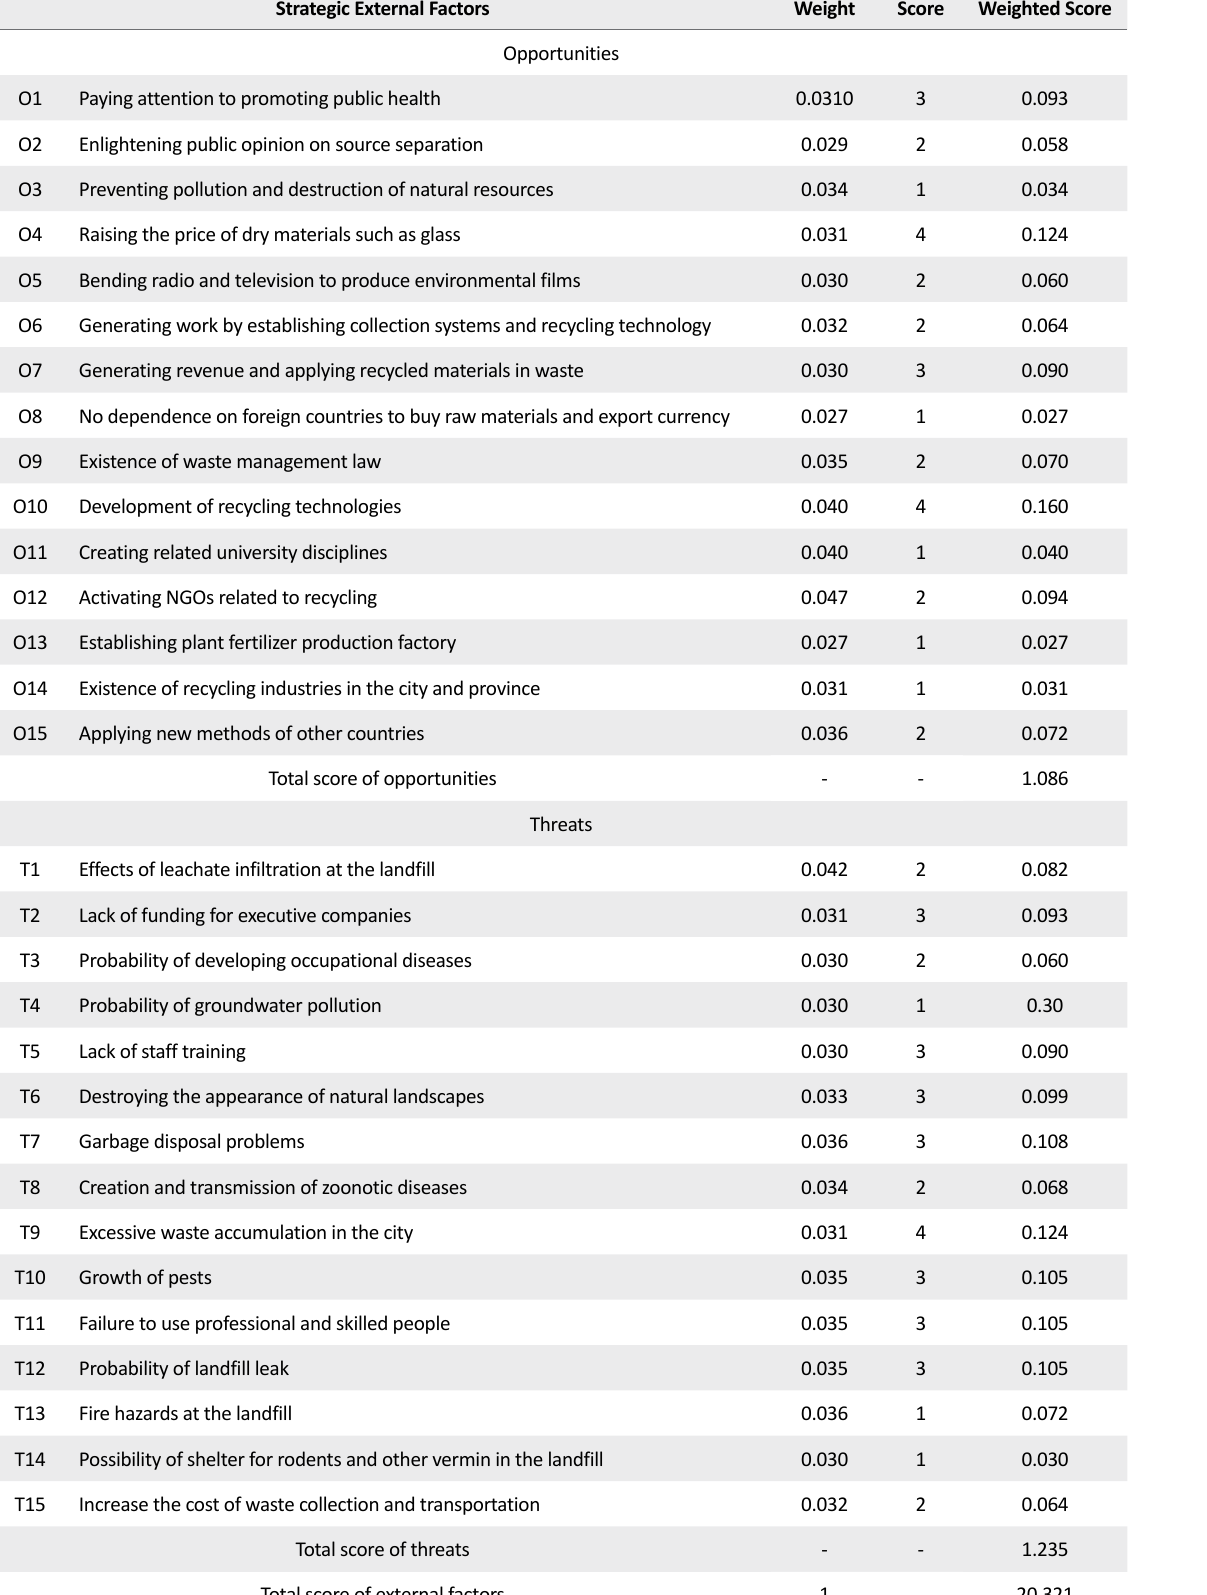
Table 3. External factor evaluation (EFE) matrix analysis of municipal waste management in Meshgin Shahr, Iran Strategic External Factors Weight Score Weighted